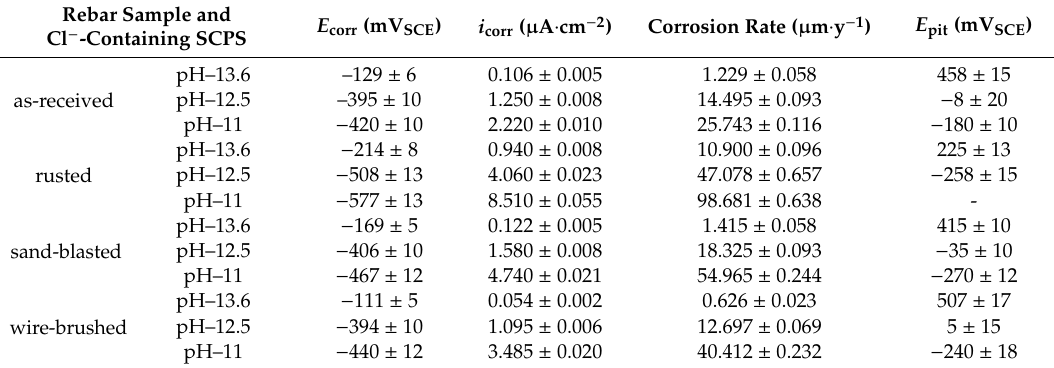
Table 3. The electrochemical parameters of the potentio-dynamic polarization (PDP) curves. Rebar Sample and Cl − -Containing